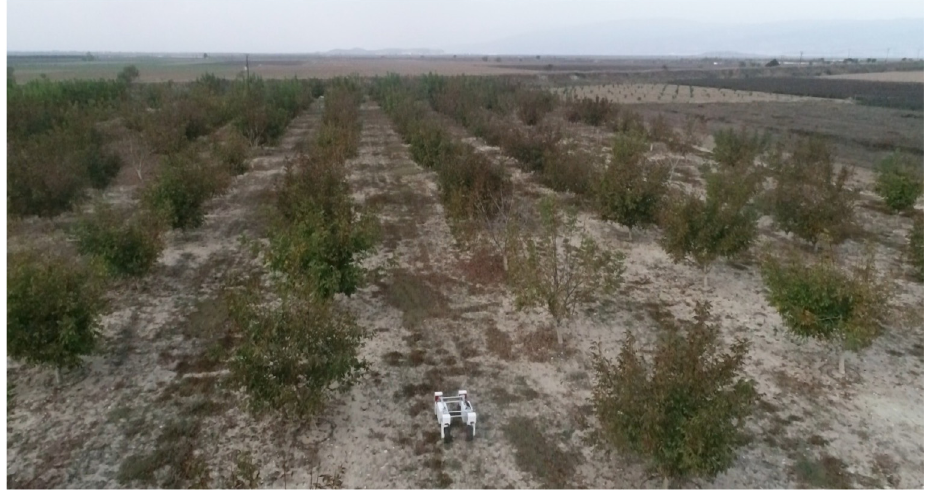
Figure 13. Unmanned vehicle (type Thorvald) in the